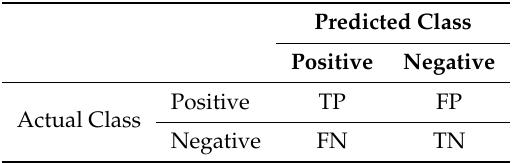
Table 1. Exemplar confusion matrix for binary